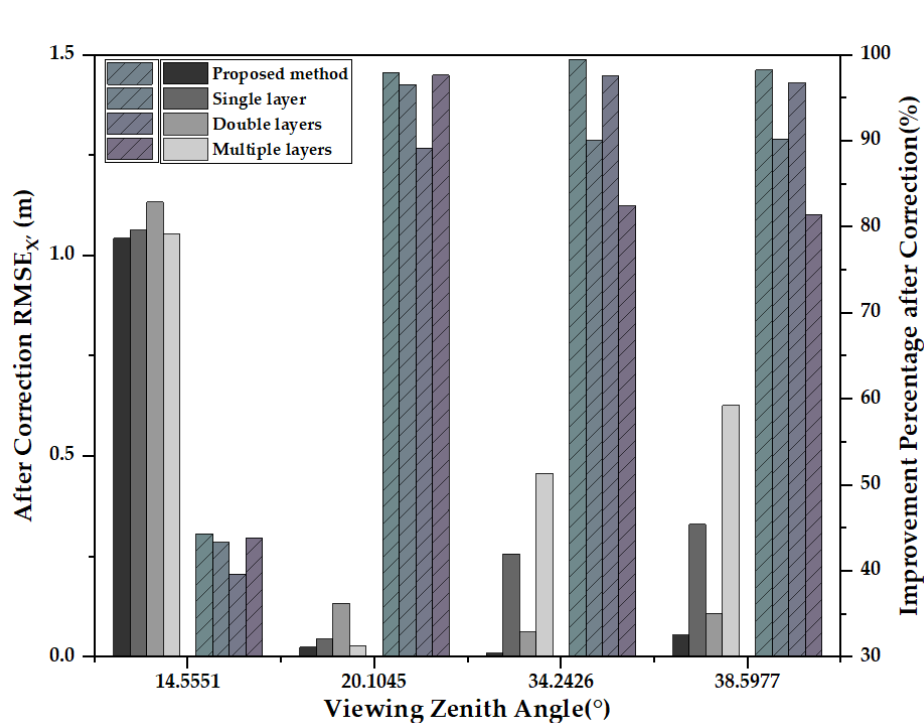
Figure 5. Histogram of the RMSE X’ (after correction) and the improvement percentage in the x-direction of different methods.